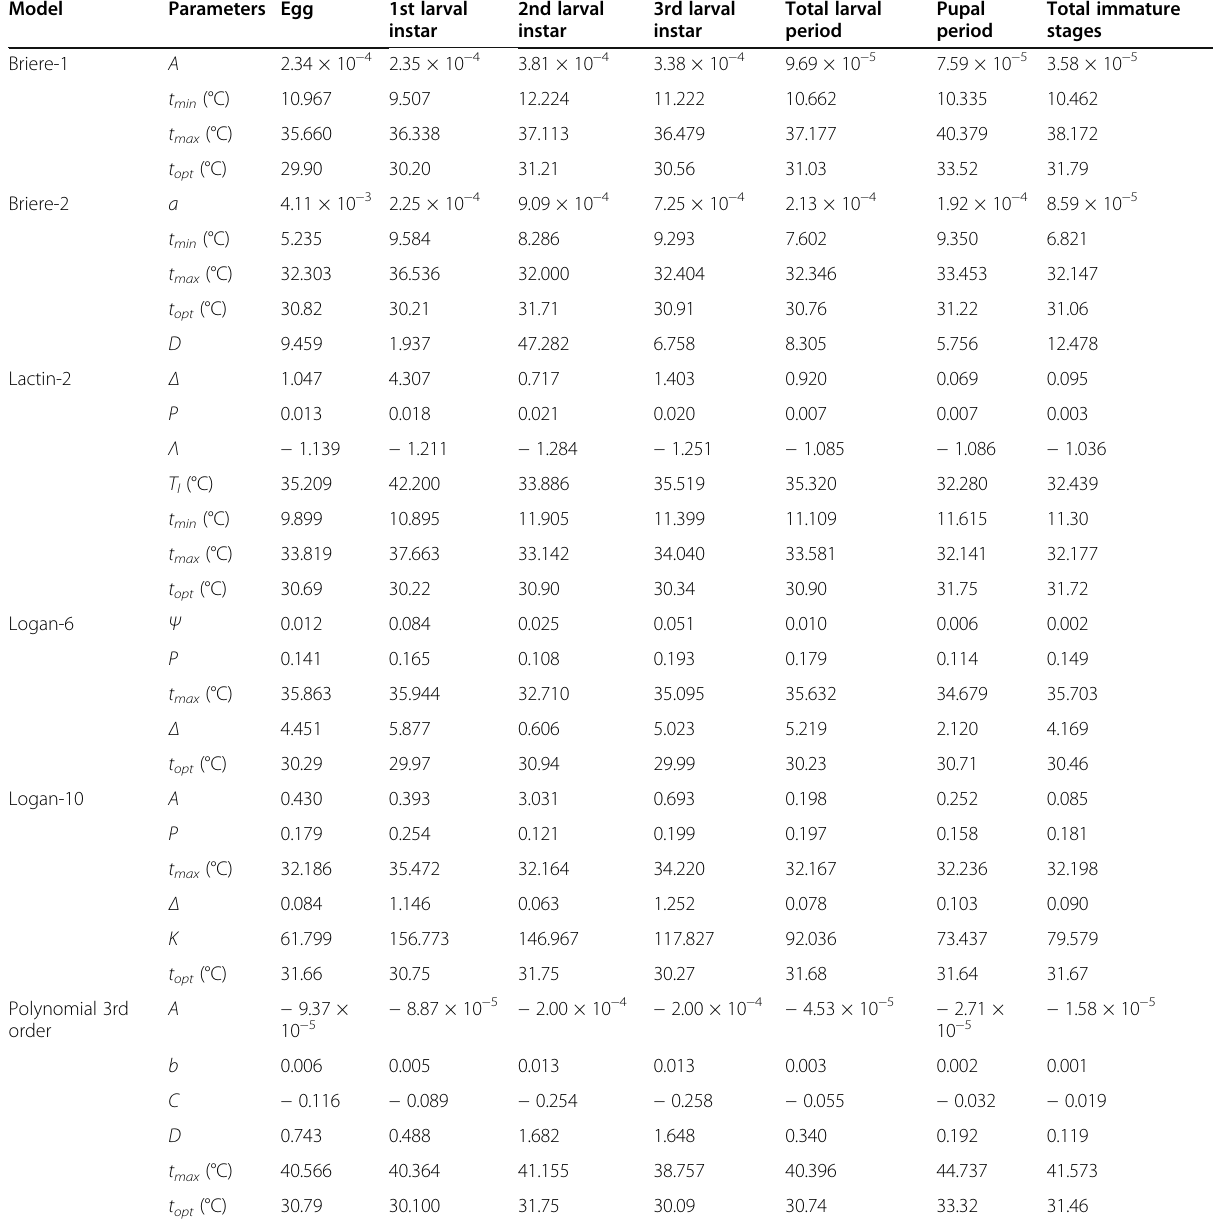
Table 4 Values of fitted coefficients and measurable parameters of 6 developmental rate models to describe immature stage development of the common green lacewing, Chrysoperla carnea